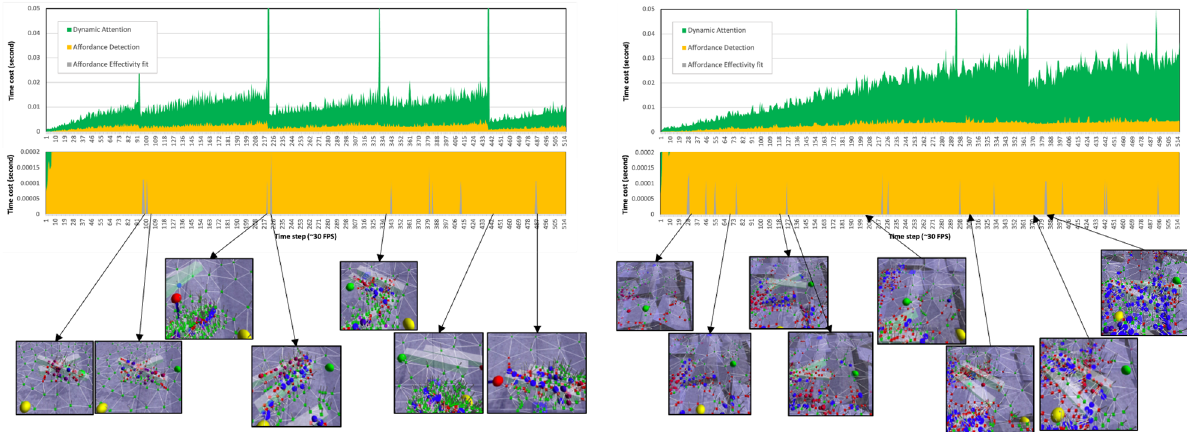
Figure 3. The computational cost analysis of affordance effectivity fit for short-term adaptation performance. There are two analysis performance, in flat terrain with sudden obstacles (see SM Video 2) and in rough terrain with sudden obstacle (see SM Video 3). The average cost in flat terrain: DA:0.01 s, AD:0.002 s, AEF: 0.00001 s. The cost increase after given by sudden obstacle. The average cost in rough terrain: DA: 0.02 s, AD: 0.003 s, AEF: 0.00001 s. The AEF is activated only when the AD module detects any obstacle obstruct the next foothold position. The captured figure, yellow sphere represents the touched foothold position (left/right), green sphere represents the next foothold position of swinging leg (left/right). The cost of CPG requires average 0.00021 s. It is quite small to effect the perception